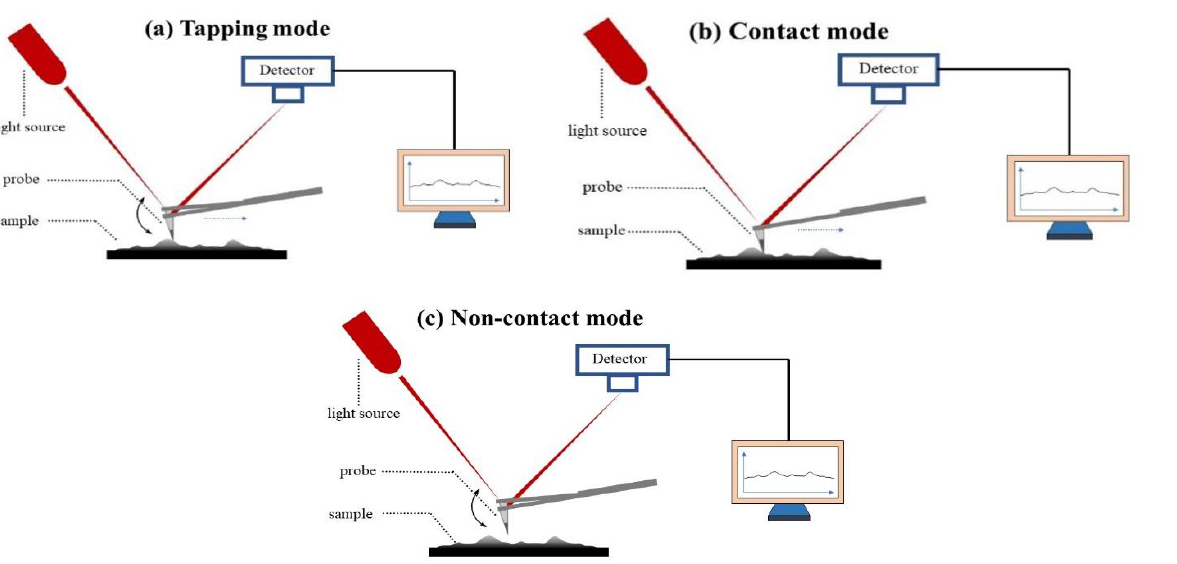
Figure 6. A schematic diagram of AFM with three different working modes: ( a ) tapping mode; ( b ) contact mode; ( c ) non-contact mode.